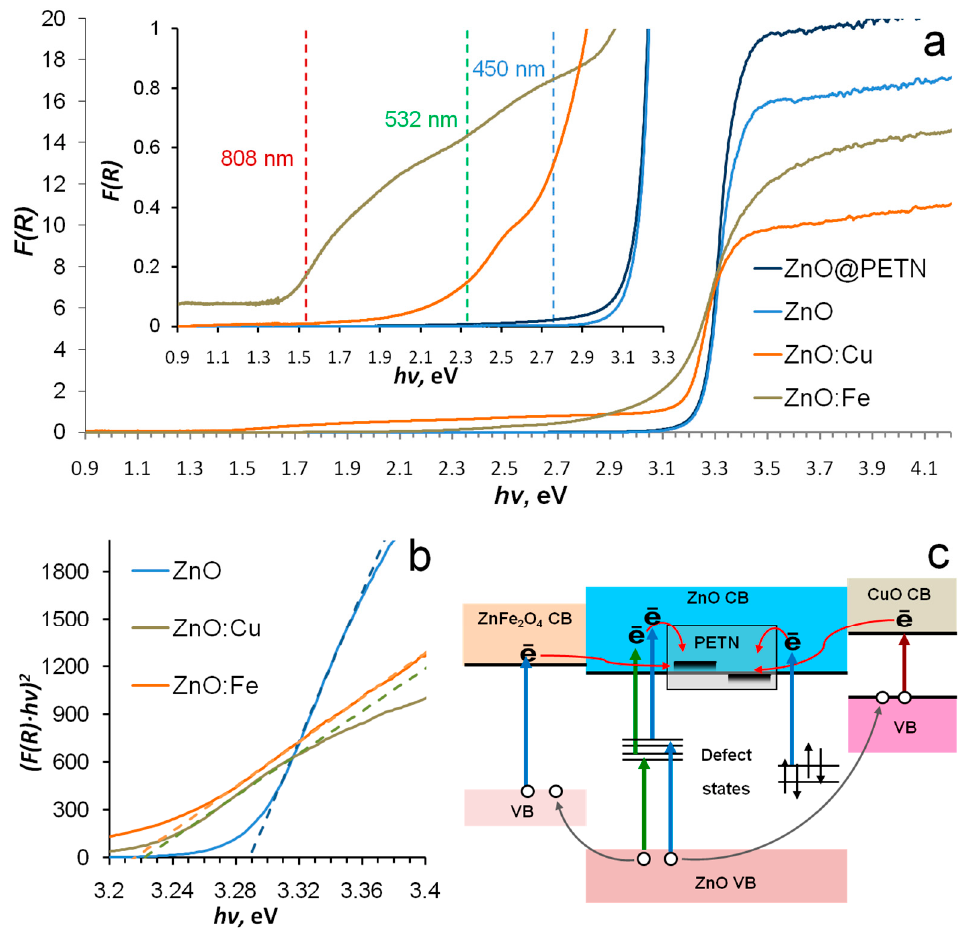
Figure 4. Diffuse reflection spectrum of the pure ZnO, ZnO:Cu, and ZnO:Fe nanopowders ( a , b ). Proposed mechanism of photoinduced charge transfer in ZnO:Fe − PETN and ZnO:Cu − PETN composites ( c ). The spectrum of ZnO nanopowder covered by PETN was also studied (Figure